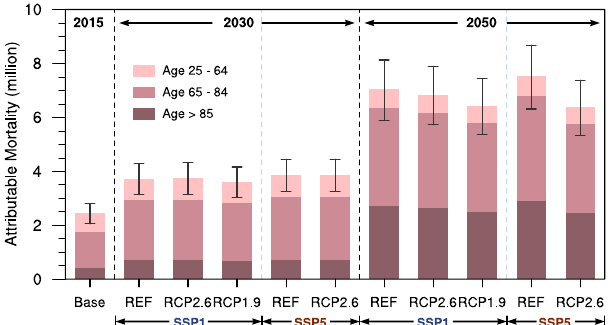
Fig. 5 Age-speci fi c mortality attributable to PM 2.5 exposure estimated by GEMM_NCD + LRI in 2015, 2030, and 2050 under various SSP_RCP scenarios in China. Data are presented as “ mean values ” of mortality with uncertain intervals based on the 95% CIs of RR. Note that relative risk in GEMM was applied for adults over 25 years